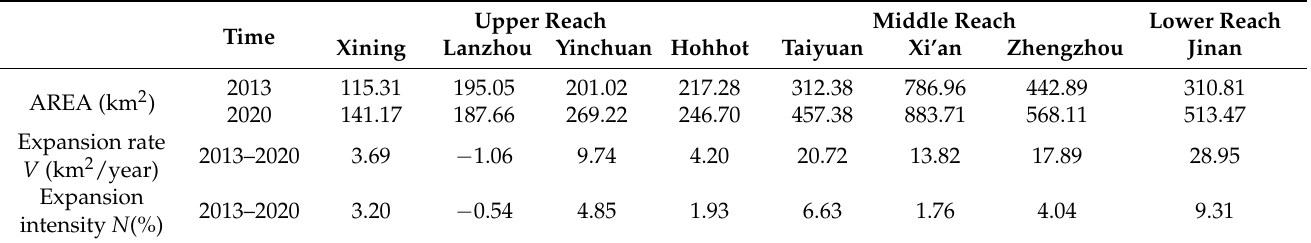
Table 2. Built-up areas of provincial capitals extracted from NTL from 2013 to 2020.